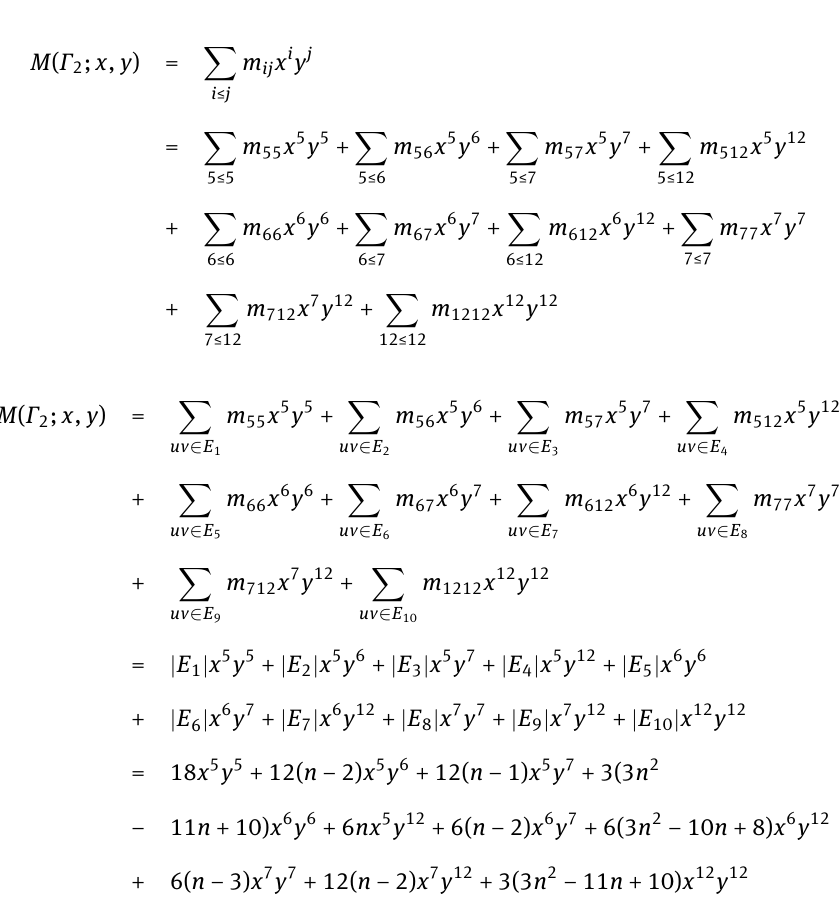
• M-Polynomial of hex-derive network HDN 2( n